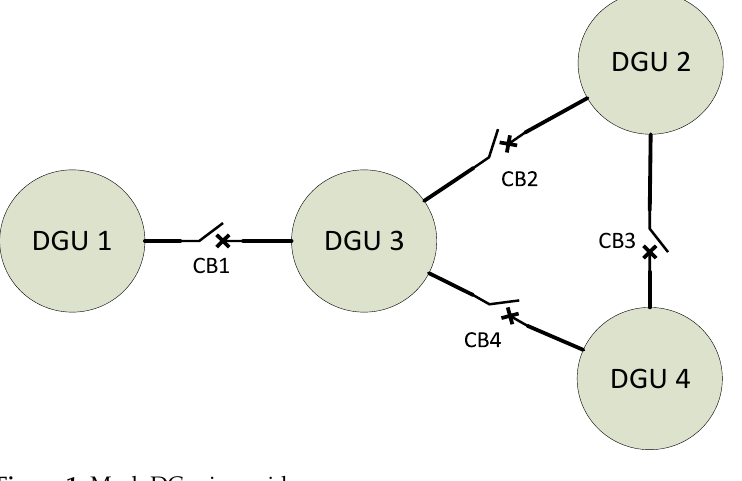
Figure 1. Mesh DC microgrid.